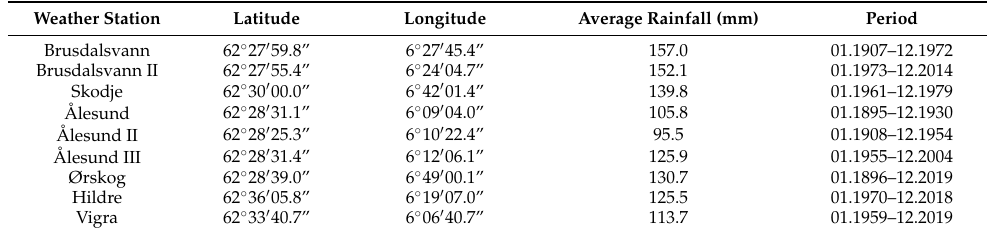
Table A1. The weather stations used in this analysis.